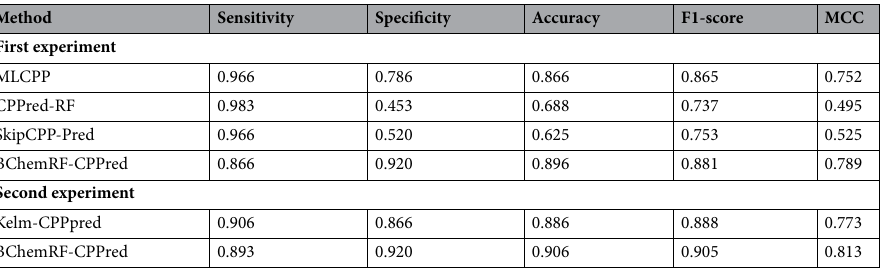
Table 2. Comparison of the performance of previous ML-based frameworks (MLCPP, CPPred-RF, and SkipCPP-Pred) and FC-4 based BChemRF-CPPred using only natural peptides from the independent dataset (1st experiment); as well as, the evaluation of the performance of Kelm-CPPpred and FC-4 based BChemRF- CPPred from all independent dataset (2nd experiment).